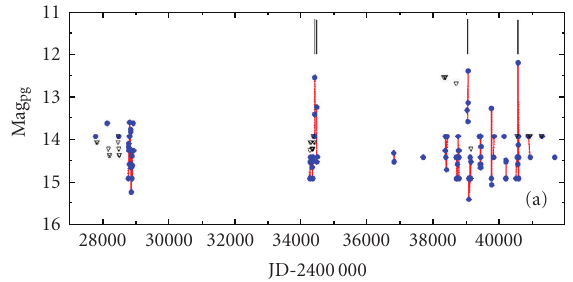
Figure 5: Long-term optical light curve of TV Col [3], where 12 optical flares have been observed so far, five of them on archival plates from the Bamberg Observatory. TV Col is an intermediate polar and the optical counterpart of the X-ray source 2A0526-328. This is the first cataclysmic variable (CV) discovered through its X- ray emission. Recently detected also by INTEGRAL